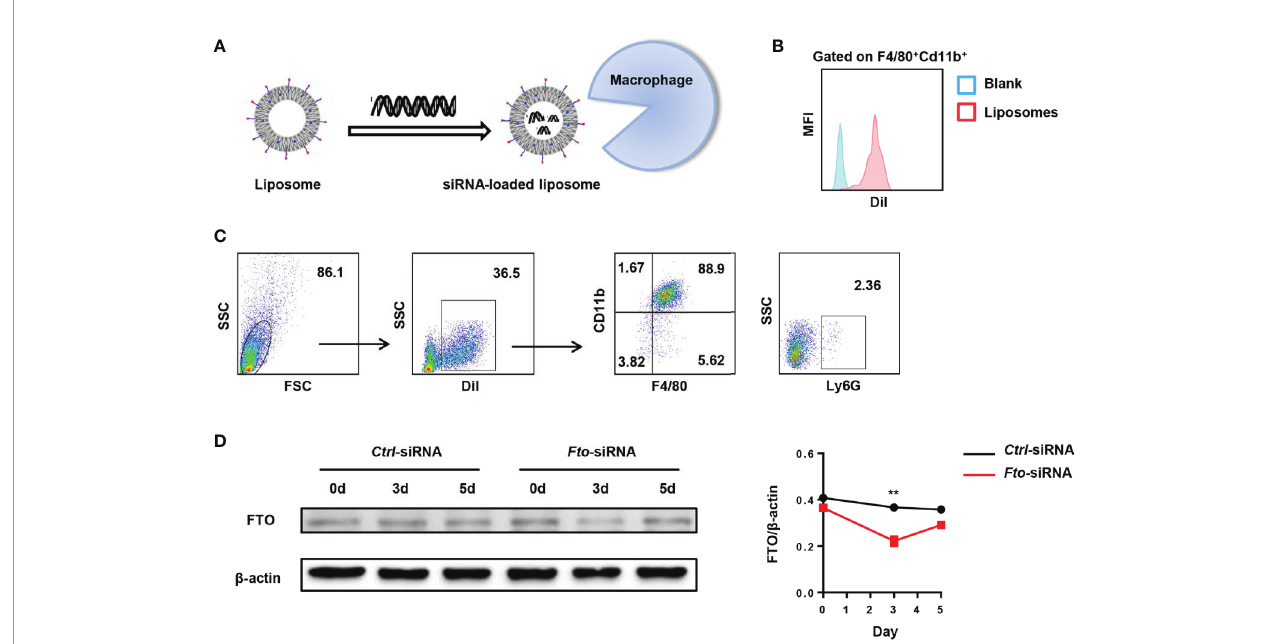
FIGURE 2 | Preparation of Fto siRNA-loaded liposomes. DiI-loaded liposomes were intraperitoneally injected in mice and the peritoneal fl uid was collected for fl uorescence analysis. (A) Schematic diagram of the preparation process of Fto siRNA-loaded liposomes. (B) The mean fl uorescence intensity of DiI in F4/ 80 + CD11b + macrophages. (C) Flow cytometry analysis of the liposomes distribution in the mouse peritoneal fl uid. (D) Temporal changes in FTO expression in the peritoneal macrophages after Fto siRNA-loaded liposomes injection. Data are shown as mean ± SEM; **P < 0.01 (two-tailed unpaired